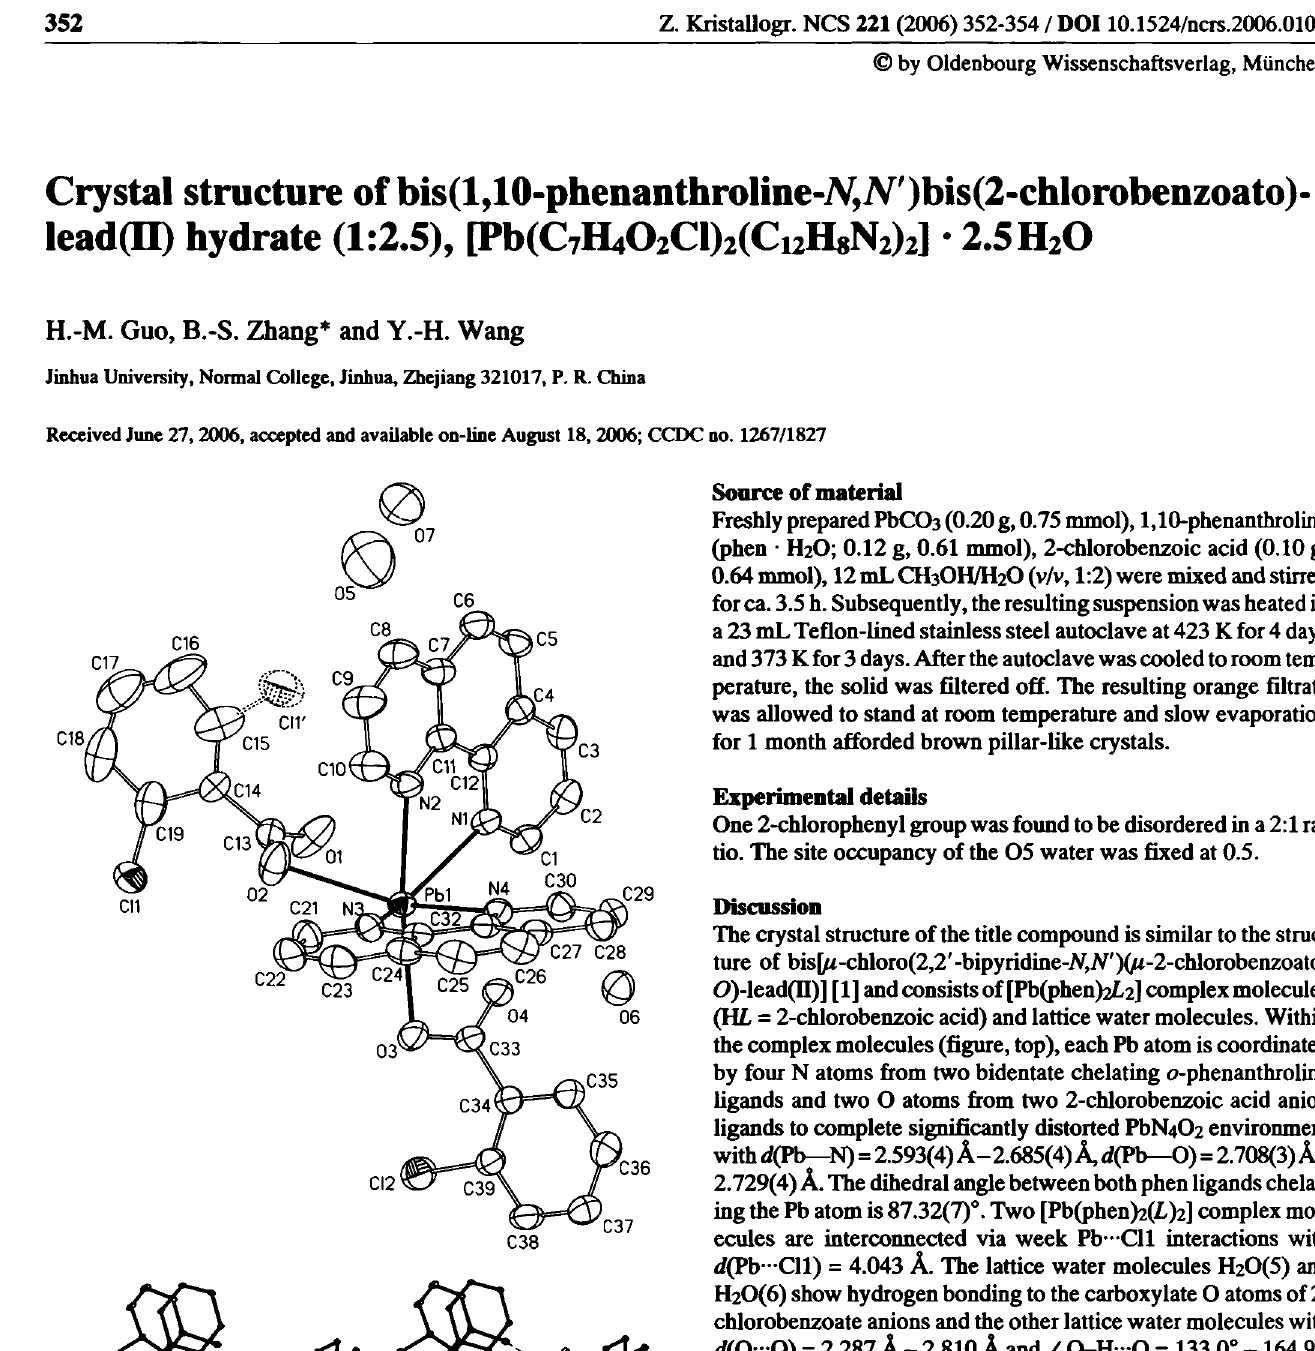
Table 1. Data collection and